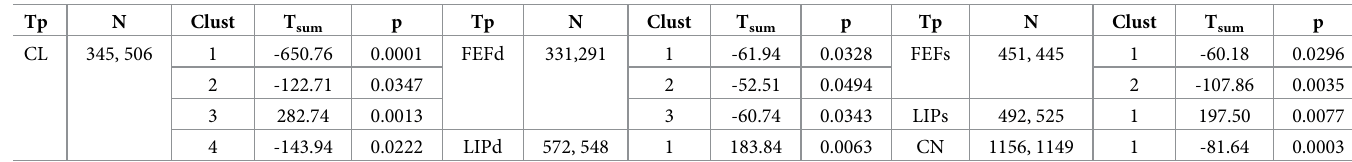
Table 1. Statistical results of cluster analysis for LFP power spectral density time-frequency spectrograms. Area identity (Tp), N (VPC, control stare), cluster identity, T sum statistic, and p-value for each significant cluster as identified in Fig 9. Positive T sum indicates VPC power spectral density > control